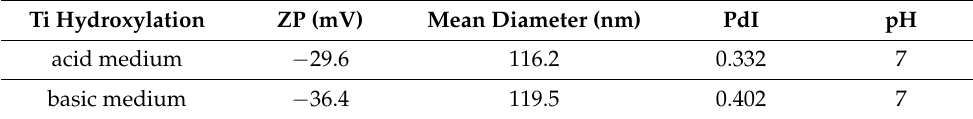
Table 3. Chemical reduction parameters of AgNPs at 25 ◦ C.